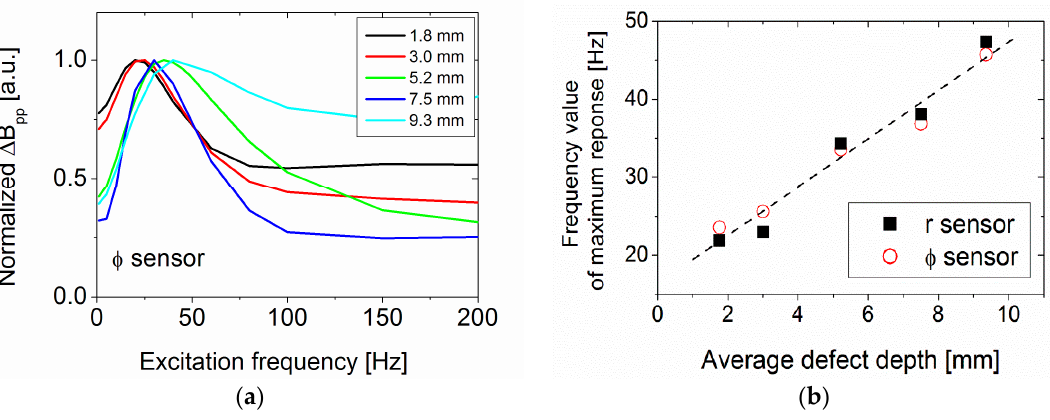
Figure 13. FEM simulations ( a ) Φ -sensor: normalized maximum peak-to-peak change in magnetic field amplitude versus frequency for defects with increasing average defect depth; ( b ) frequency of maximum response from ( a ) versus defect depth.